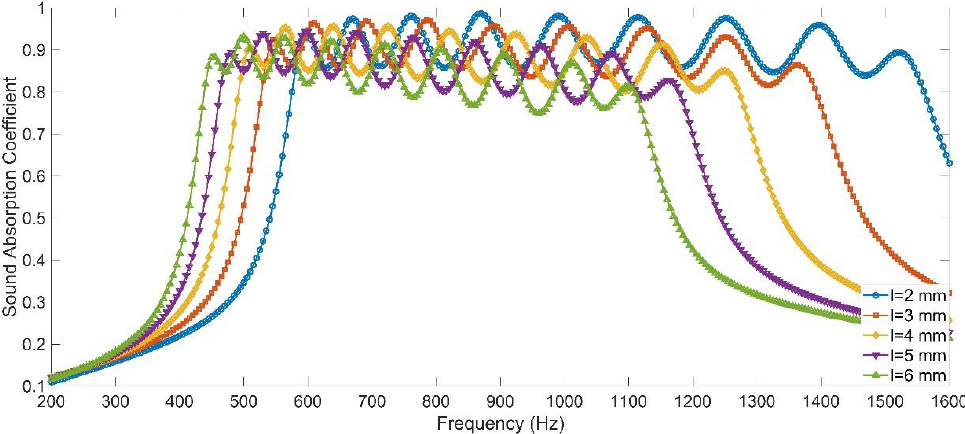
Figure 14. The sound absorption performance of the APH-AM with variable length of the aperture achieved in simulation.